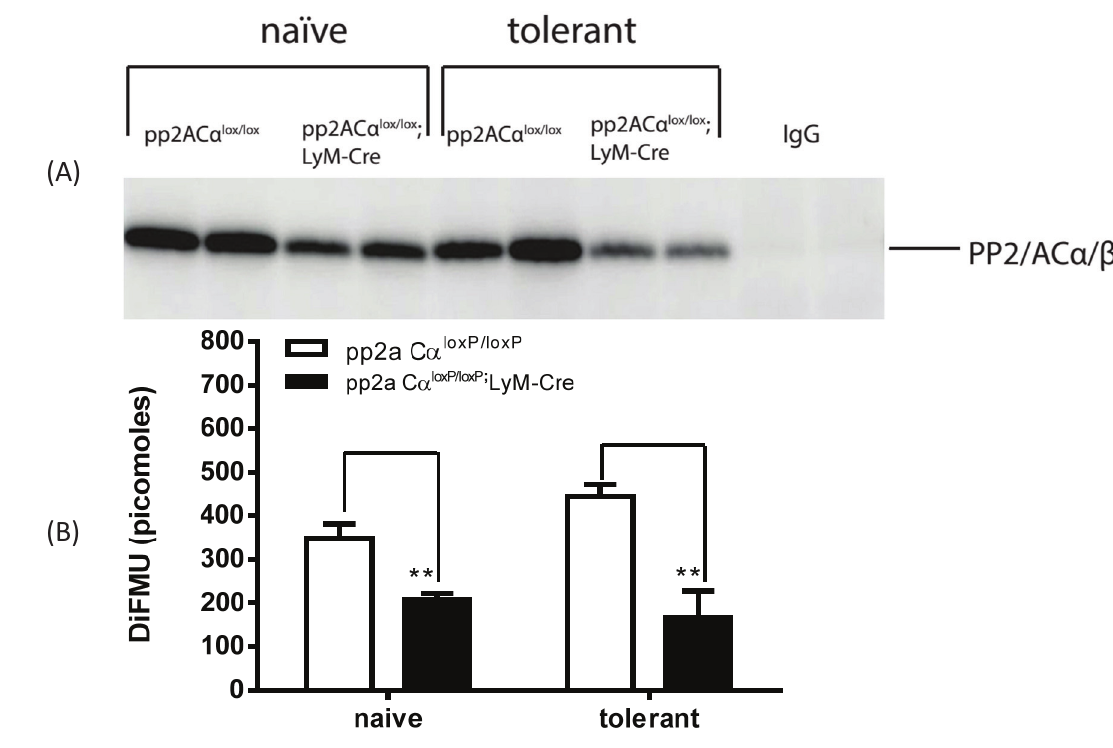
Figure 5. PP2A activity in control and pp2AC(cid:2) knockout macrophages under both naïve and knockout conditions. Elicited peritoneal macrophages were pretreated with (tolerant) or without (naïve) 100 ng/mL LPS for 24 h. Total cell lysates were incubated with antibody cross-linked beads (control mouse IgG or anti-PP2A IgG) as described in Figure 3. Beads were incubated with phosphatase assay buffer containing DiFMUP and NiCl 2 at 30 °C for 30 min. Supernatants were then removed and assayed for phosphatase activity. ( A ) Beads were boiled in 2 × SDS-PAGE loading buffer and protein bound to the beads was probed for PP2A; ( B ) PP2A activity. In control cells (PP2AC(cid:2) l ° x/l ° x ), tolerance induced an upregulation of phosphatase activity; whereas in PP2AC(cid:2) knockout macrophages (PP2AC(cid:2) l ° x/l ° x ;lyM-Cre), PP2A activity was